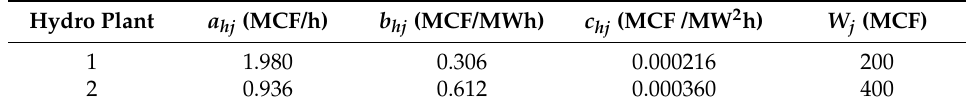
Table A2. Hydraulic data of hydro units of the IEEE 30 buses system.